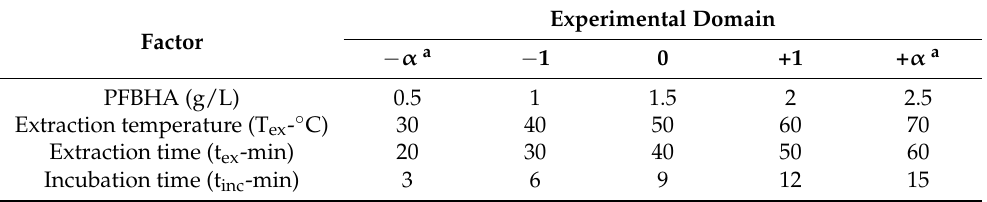
Table 1. FactorlevelsandexperimentaldomainappliedtooptimizetheHS-SPMEexperimentalconditions.